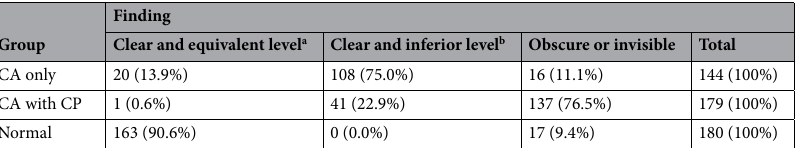
and were assigned as “clear and equivalent level”. Second, 149 lines on the affected side were clearly visible but located at an inferior level relative to those on the unaffected side. This finding was defined as “clear and inferior level”. Third, 170 images were assigned as “obscure or invisible”, as they showed an obscure or invisible line on the affected side or on at least one side. The distributions of these three findings were significantly different among the three groups (p < 0.001). In the CA only group, most of the lines showed the finding of “clear and inferior